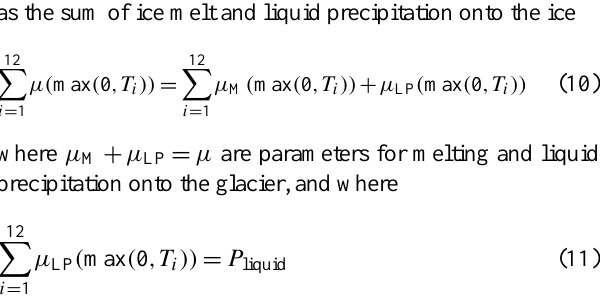
Fig. 9. Timeseries of the reconstruction for Hintereisferner. (a) green: MB measured , black: MB model , light gray shading: ± 2 · rmse model , cross , dark gray shading: ± 1 · rmse model , cross . (b) annual temperature anomaly at the location of the glacier. (c) annual precipitation anomaly at the location of the glacier. (d) red: MB modeled using full variability in temperature, but climatological monthly precipitation, light red shading: ± 2 · rmse ± 1 · rmse model , cross , dark red shading: model , cross . (e) blue: MB modeled using full variability in precipitation, but climatological monthly temperatures, light blue shading: ± 2 · rmse model , cross , dark blue shading: ± 1 · rmse model , cross . (f) red: correlation in a running 10-yr window between d and a, blue: correlation in a running 10-yr window between e and a, correlations below the 95% confidence intervall are omitted from the plot. (g) green: MB measured , black: MB mean model , light gray shading: ± 2 · rmse mean model , cross , dark gray shading: ± 1 · rmse mean model , cross